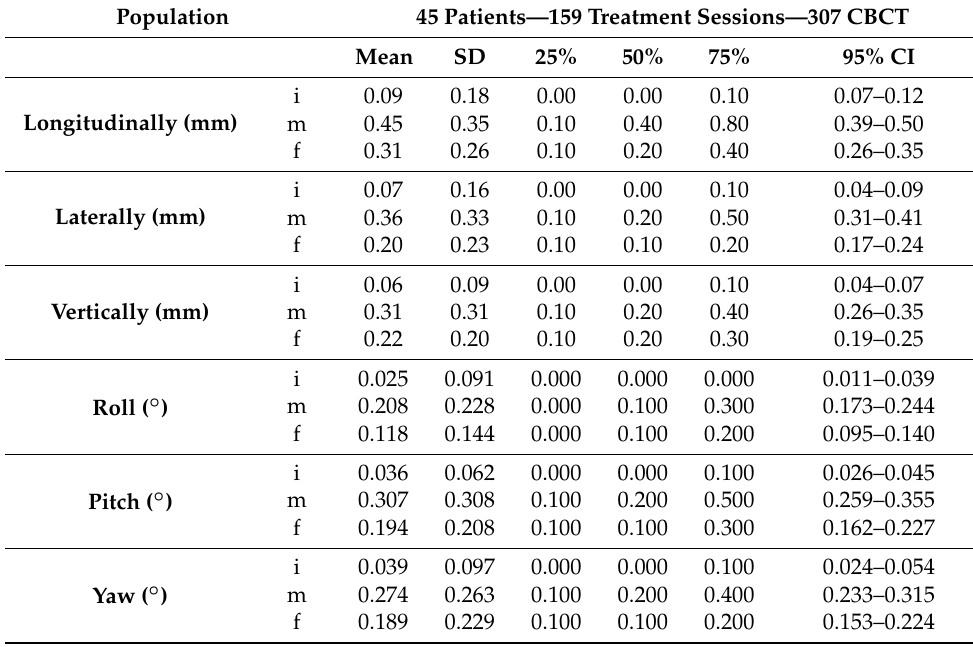
Figure 1. 95% CI for inter- and intrafraction ( A ) translational and ( B ) rotational values. Data regarding SGRT were reported in Table 4. In Figure 2 the 95% CI were showed for SGRT values. Table 4. Intrafraction SGRT main summary statistical